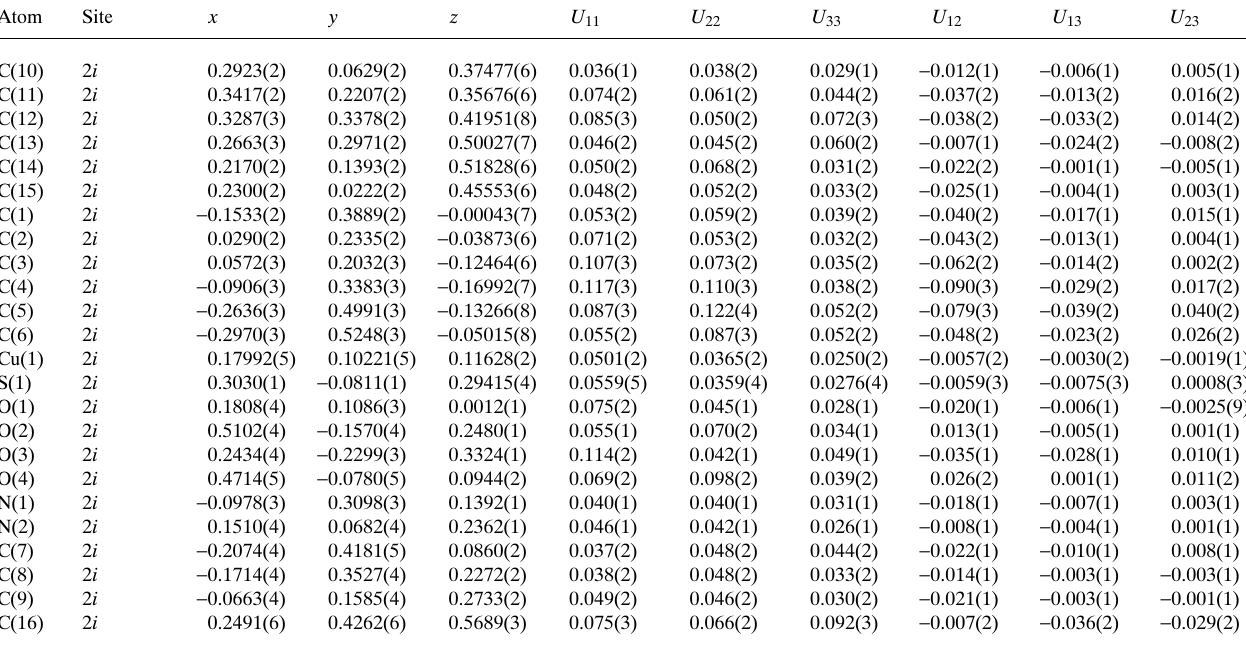
Table 3. Atomic coordinates and displacement parameters (in Å 2 ) .